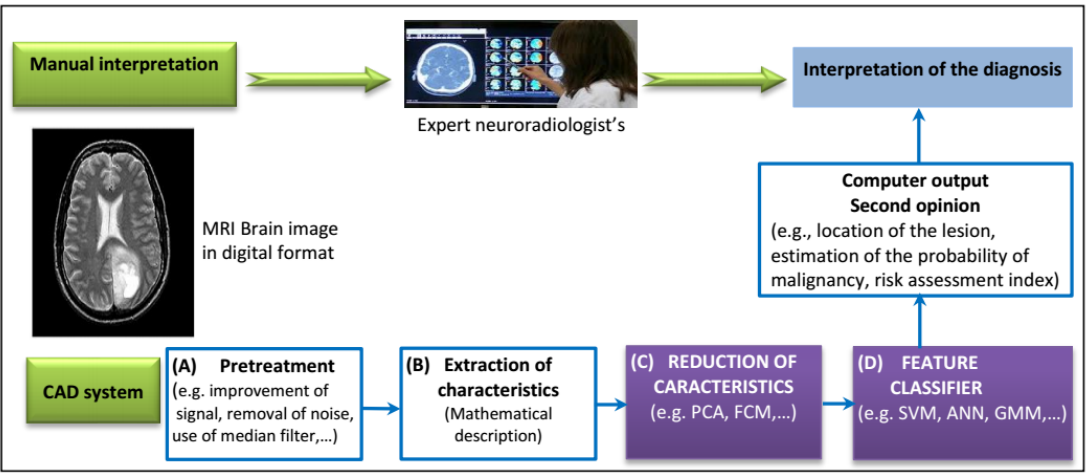
Figure 1. Schematic diagram for magnetic resonance imaging (MRI) brain image interpretation (top) and overall block diagram of the corresponding computer-aided diagnosis (CAD) system (bottom).